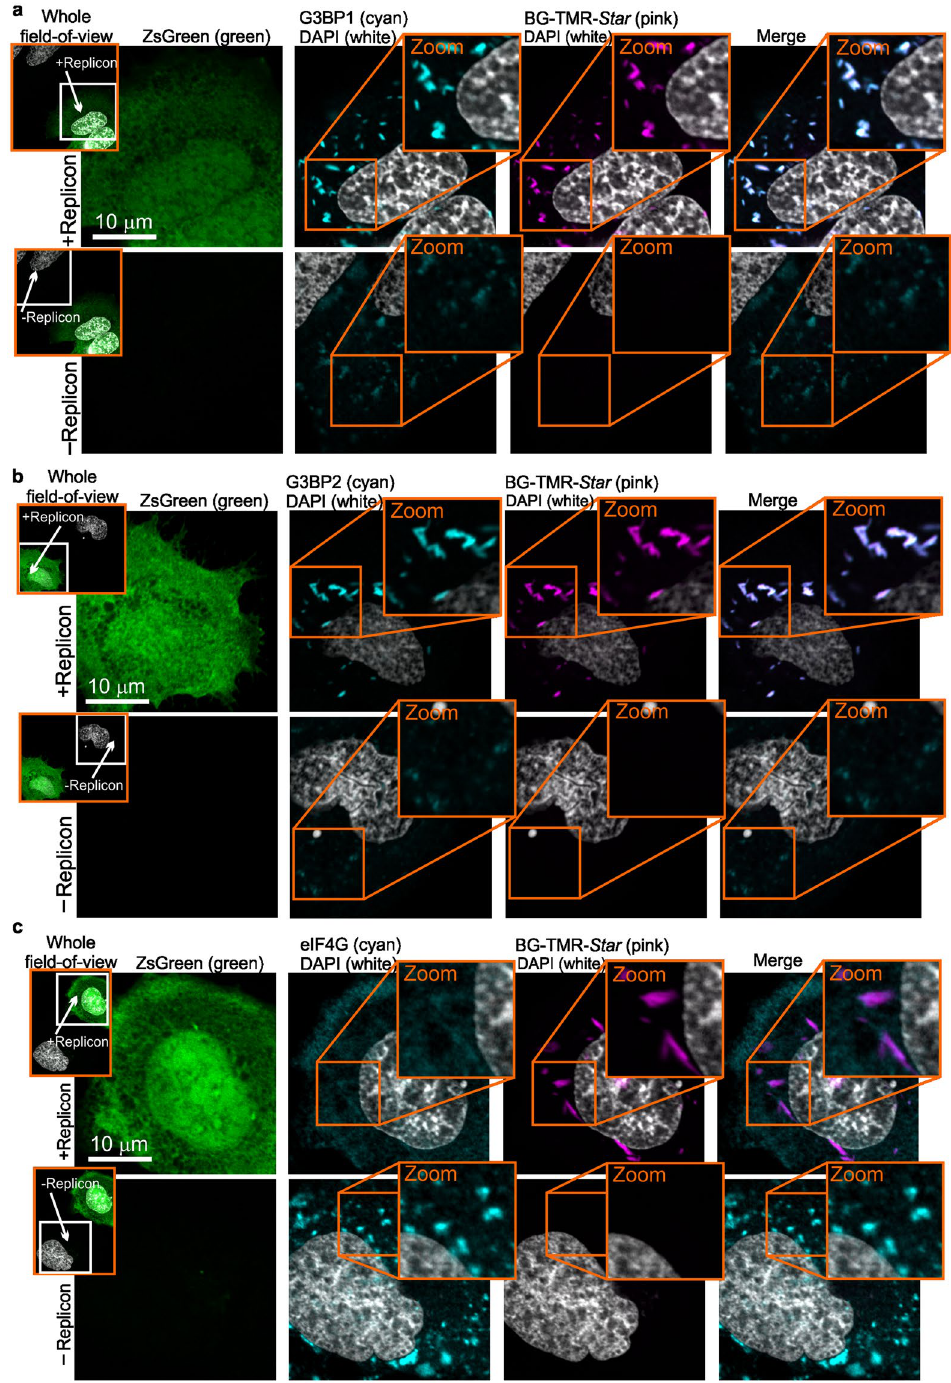
Figure 4. SNAP-nsP3 retains known function and interaction with G3BP1/2 cellular proteins. CHIKV SNAP-nsP3 sg-ZsGreen RNA was transfected into HuH-7 cells by electroporation. After 11 h, stress granules were induced by sodium arsenite treatment (1 mM, 45 min), followed by fixation and staining for SNAP-nsP3 by BG-TMR- Star (pink). Nuclei were counterstained with DAPI (cyan). Data was acquired with a Zeiss LSM 880 confocal system with Airyscan, operated in the super-resolution mode with a Plan-Apochromat 63 × oil objective (1.4 numerical aperture). ( a ) G3BP1 (cyan) was immunostained with mouse antibodies that bind to G3BP1. SNAP- nsP3 co-localised with G3BP1 in ZsGreen-positive cells. Inserts on the left show entire field-of-view from which individual regions were selected that either contained a ZsGreen-positive cell ( + Replicon) or a ZsGreen-negative cell ( − Replicon). Inserts on the right represent zoomed-in views of boxed regions. Rightmost images show overlays of the signals from the indicated fluorescent channels (G3BP1/2-specific signal pseudo-coloured in cyan, BG-TMR- Star in pink). ( b ) G3BP2 (cyan) was immunostained with rabbit antibodies that bind to G3BP1. SNAP-nsP3 co-localised with G3BP2 in ZsGreen-positive cells. ( c ) Stress granule marker eIF4G (cyan) was immunostained with antibodies that bind eIF4G. SNAP-nsP3 did not sequester eIF4G in ZsGreen-positive